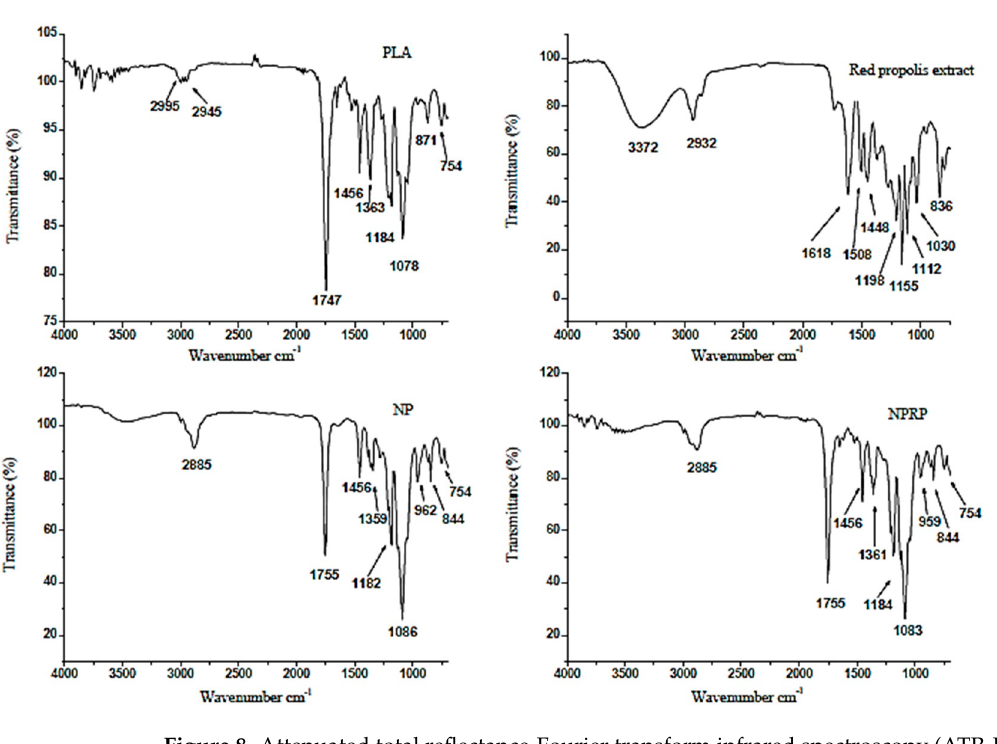
Figure 8. Attenuated total reflectance-Fourier transform infrared spectroscopy (ATR-FTIR) related to the PLA, RPE, NPs, and NPRP.